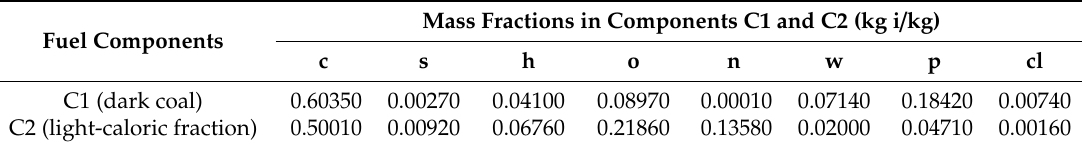
Table 5. Mass composition of components C1 and C2.